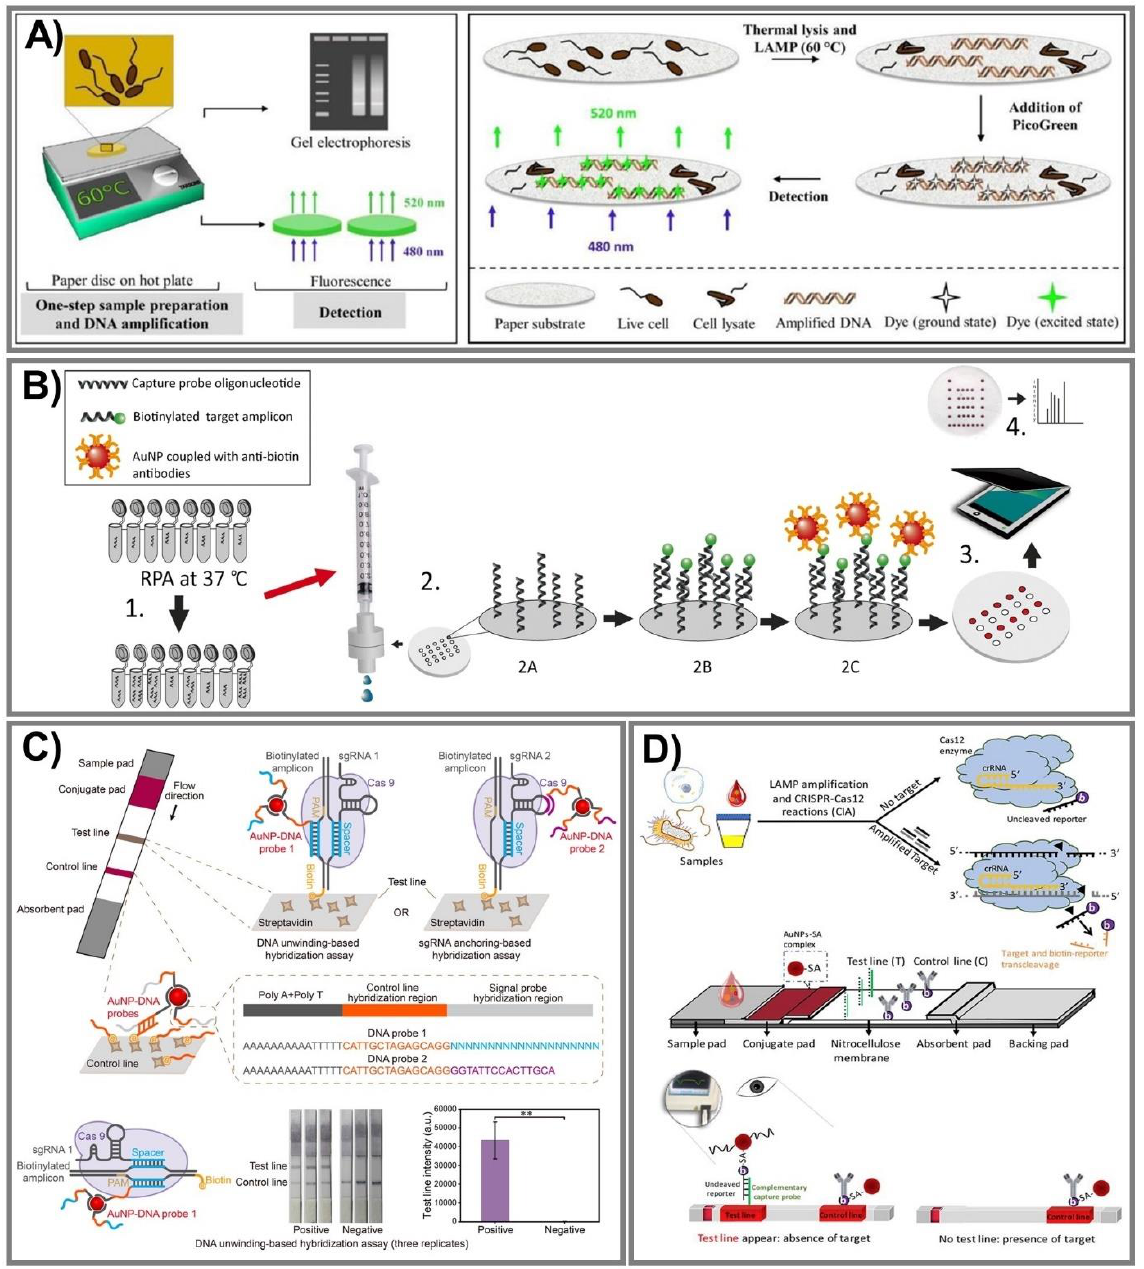
Figure 8. Nucleic acid-amplified PADs. ( A ) One-step lysis to amplify DNA for E. coli and M. smegmatis in a LAMP system through recorded fluorescence intensities by the binding of DNA with PicoGreen dye. Adapted with permission from Ref. [161] . ( B ) The process for human adenoviral detection was carried out by novel RPA vertical flow-paper microarray based on the visualization of anti-biotin antibody-conjugated AuNPs with positive spots. Adapted with permission from Ref. [170] . ( C ) The CRISPR/Cas9-mediated lateral flow nucleic acid assay was established to identify L. monocytogenes and African swine fever virus (ASFV) in swine serum samples. Adapted with permission from Ref. [177] . ( D ) An ultrasensitive CRISPR/Cas12 lateral flow sensor was developed by integrating Cas12a and Cas12b effectors to determine Pseudomonas aeruginosa — a multidrug-resistant infection. Adapted with permission from Ref. [178] .